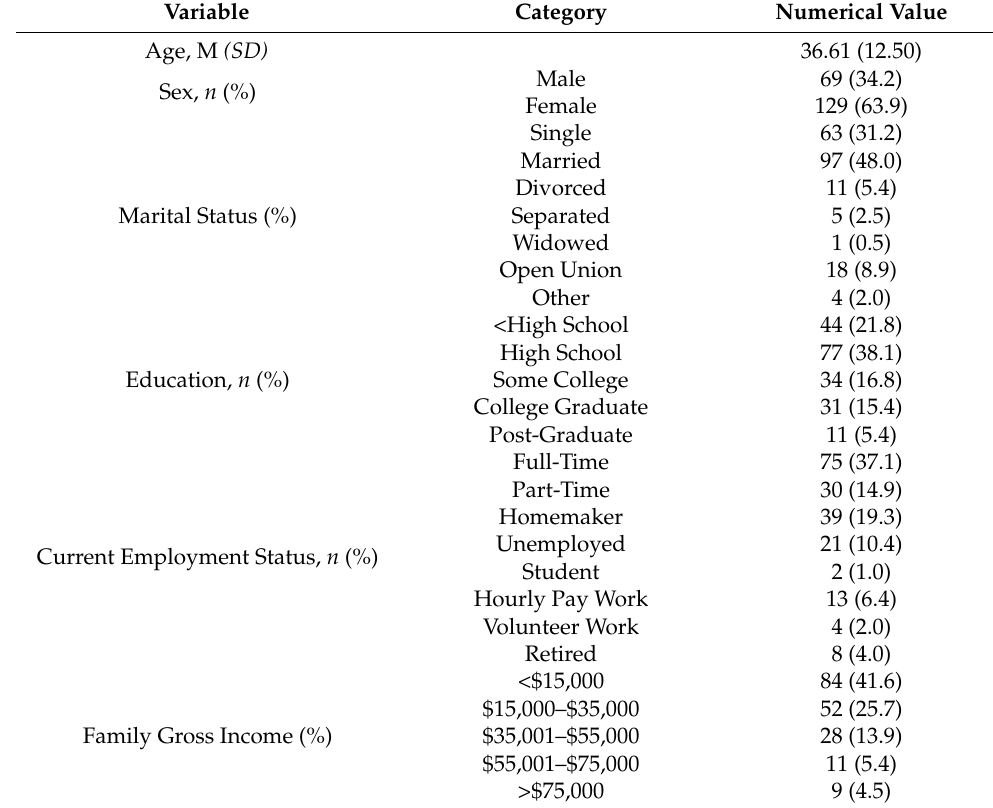
Table 1. Participant